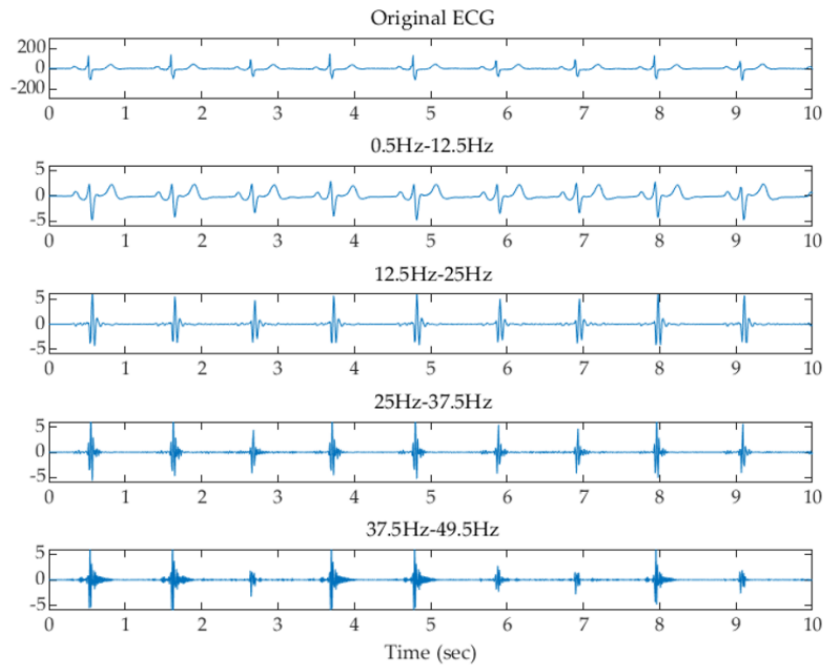
Figure 4. Examples of the original ECG and the signals after filtering using the filter bank with 4 Butterworth filters and z-score